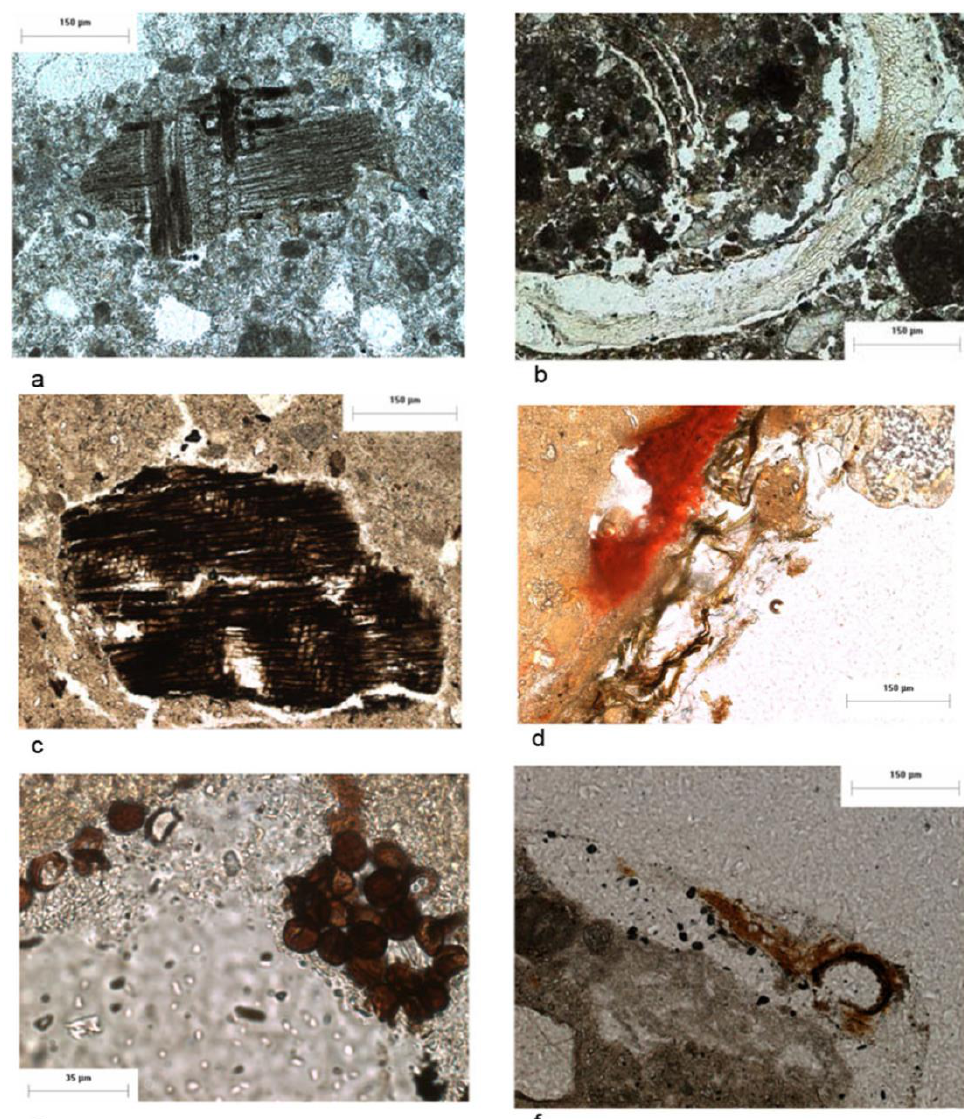
Figure 7. Thin sections microphotographs of organic inclusions. ( a ) woody tissue; ( b ) vegetal, non woody, tissue; ( c ) vegetal charcoal; ( d ) cyanobacteria; ( e ) possible sporangium; ( f ) possible lichen